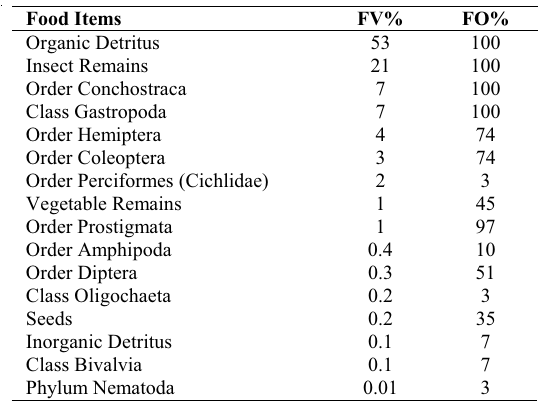
Table 1. Volumetric frequencies (FV%) and occurrence fre- quencies (FO%) of food items consumed by Arapaima gigas. Food Items